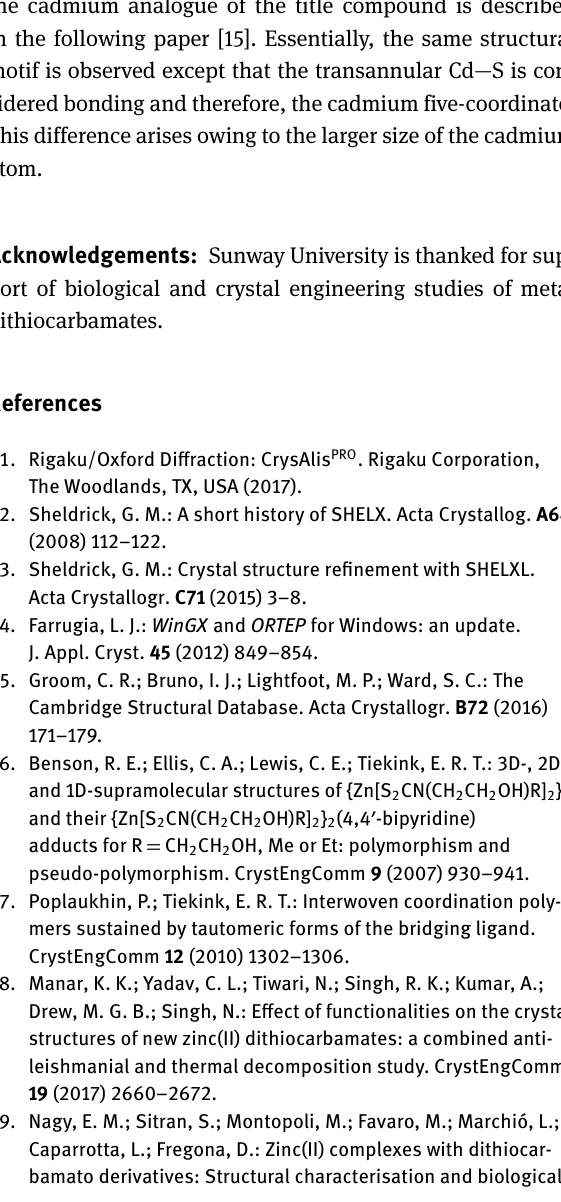
separated from the zinc atom by 2.9512(5)